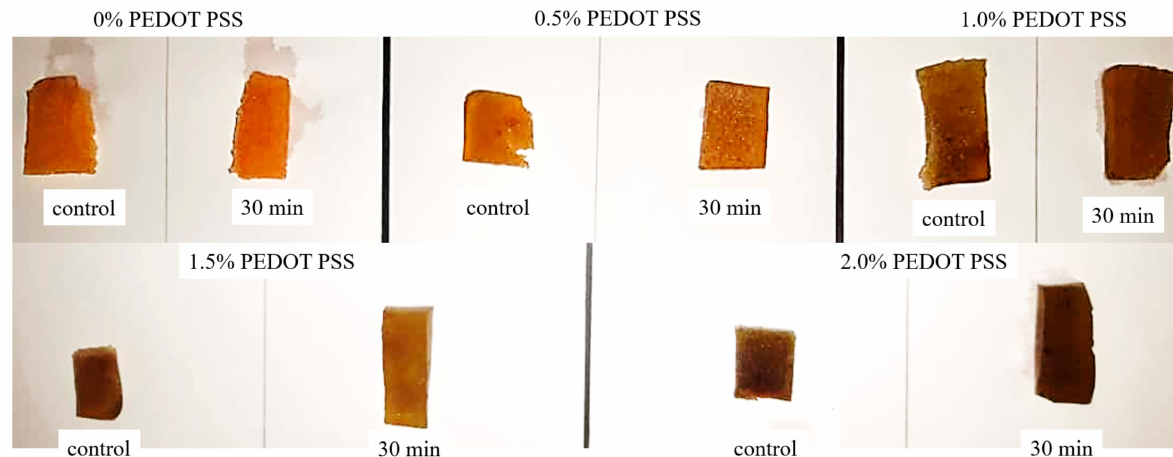
Figure 16. The physical appearance of all fabricated hydrogels before and after the immersion process in PBS solution.